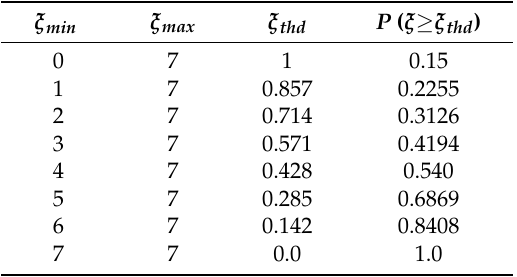
Table 2. Threshold and probability of the Critical Data